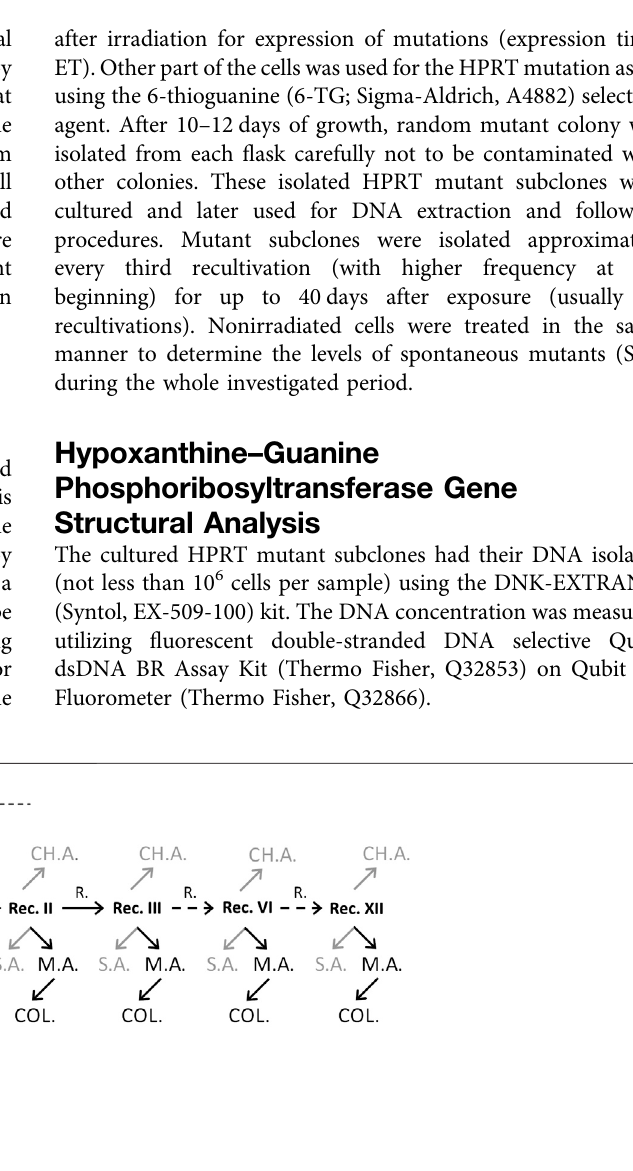
Frontiers in Physics |